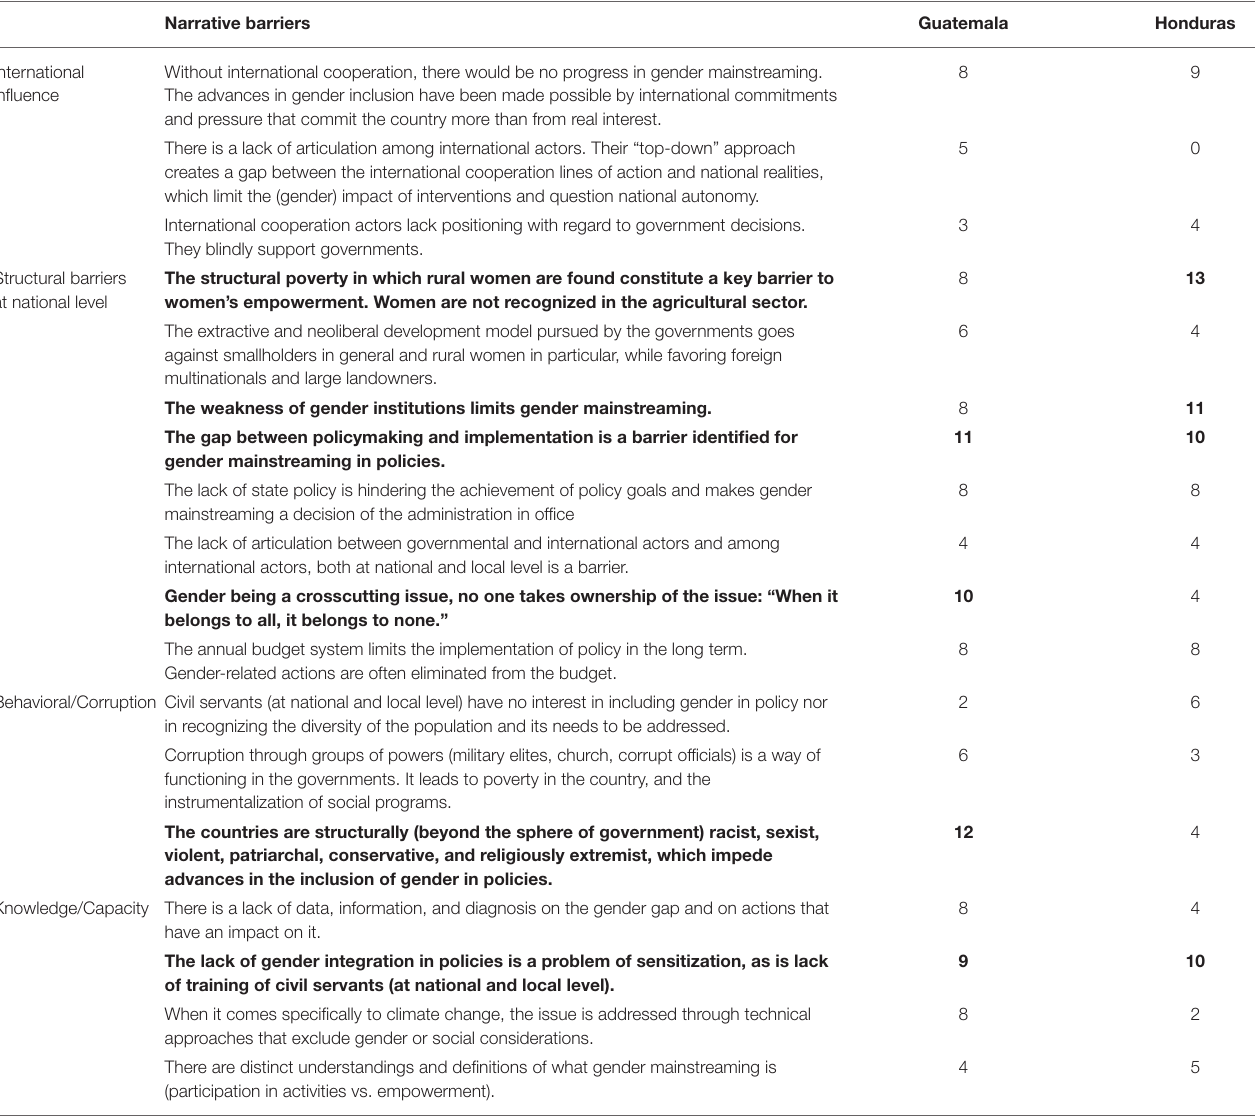
TABLE 3 | Synthesis table of most mentioned barriers for gender mainstreaming in Guatemalan and Honduras policies. Narrative